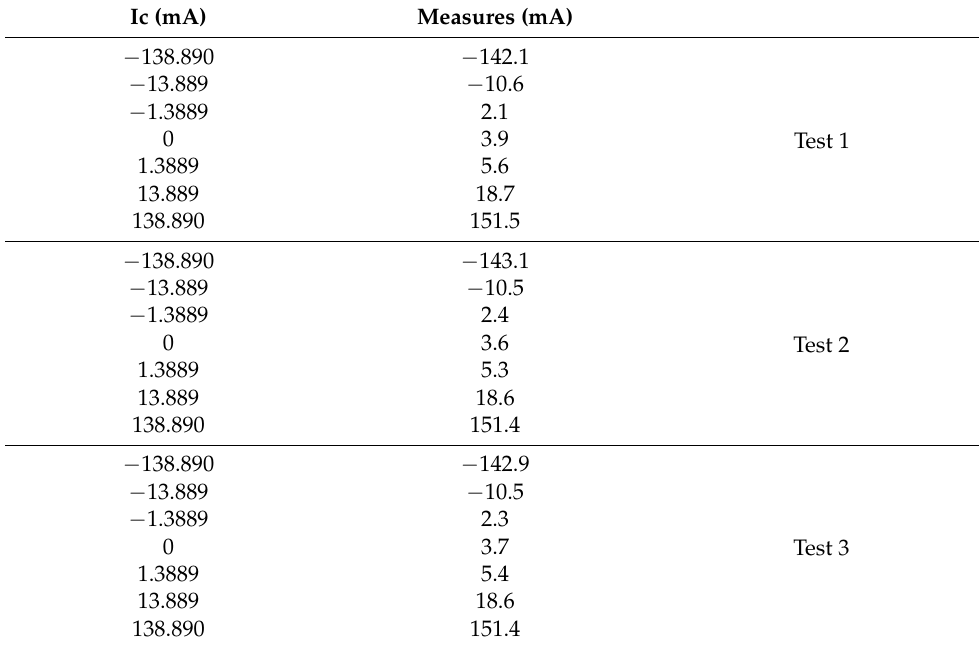
Table 1. Calibration of the system in the digital-analog converter (MCP4725).